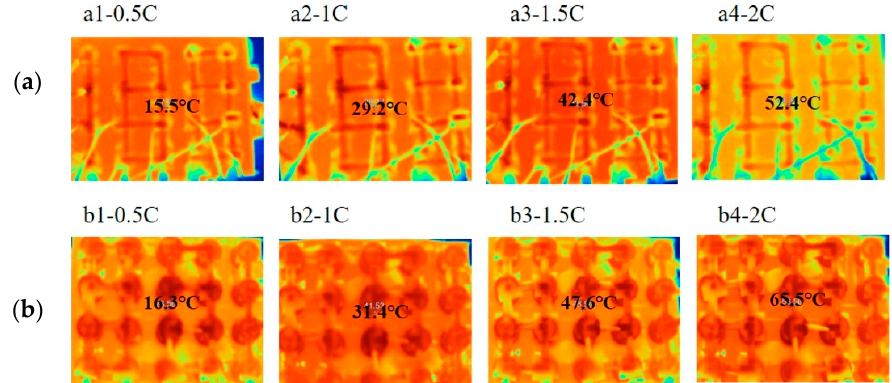
Figure 3. Temperature distribution of the Li-ion battery pack for discharge rates 0.5C, 1C, 1.5C and 2C at − 10 °C: ( a ) with RT44HC/EG composite; ( b ) without PCM. Reproduced from [34] with permission from Elsevier.